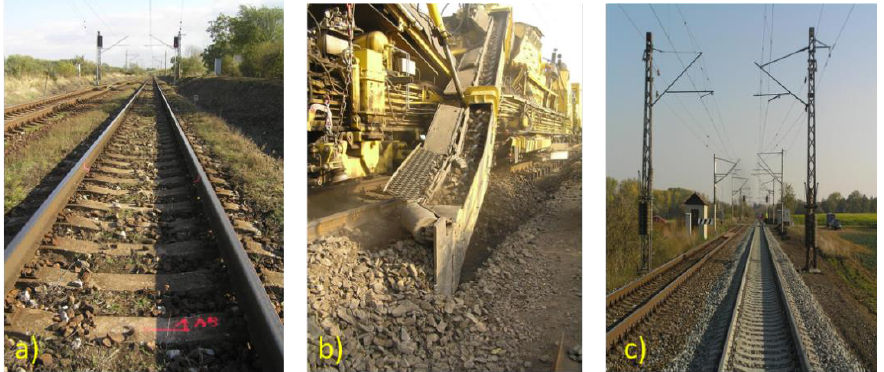
Figure 4. Track condition ( a ) before (phase 3), ( b ) during, and ( c ) after construction activities (phase 5).